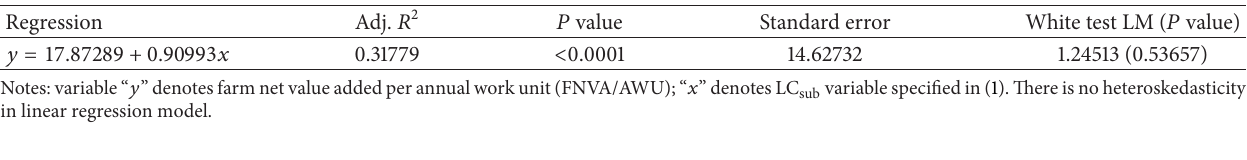
Table 6: Regression between income indicators FNVA/AWU (thousand EUR) and LC